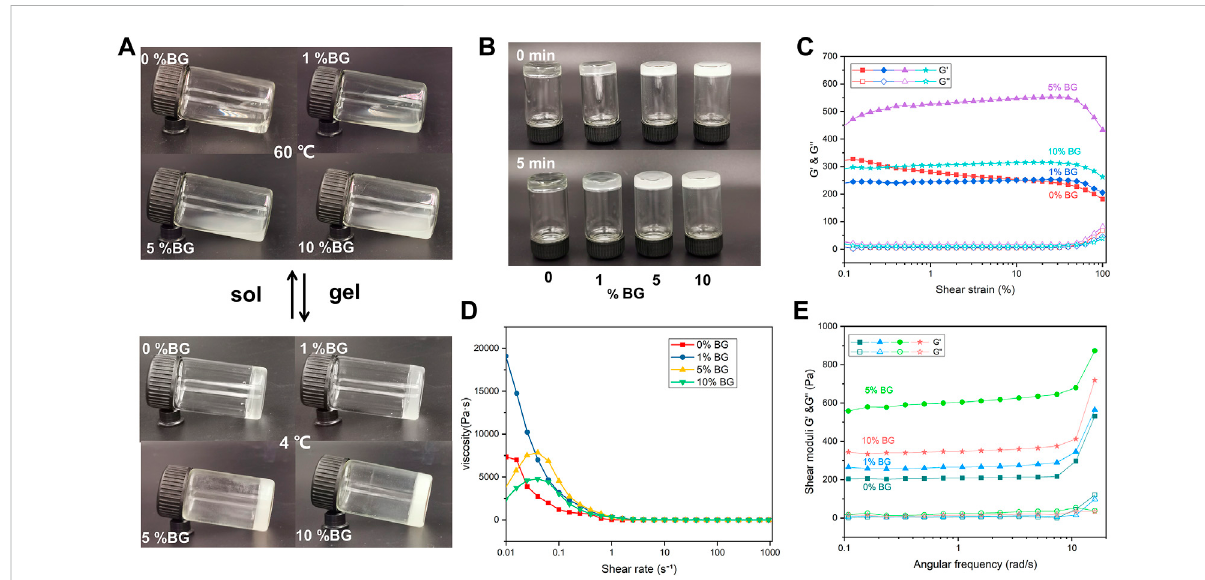
FIGURE 2 RheologicalpropertiesoftheBG/GelMAbiomaterial ink: fl owbehaviorof0%,1%, 5%,and10%BG (A) at60 ° Cand 4 ° C (B) after0 min and5